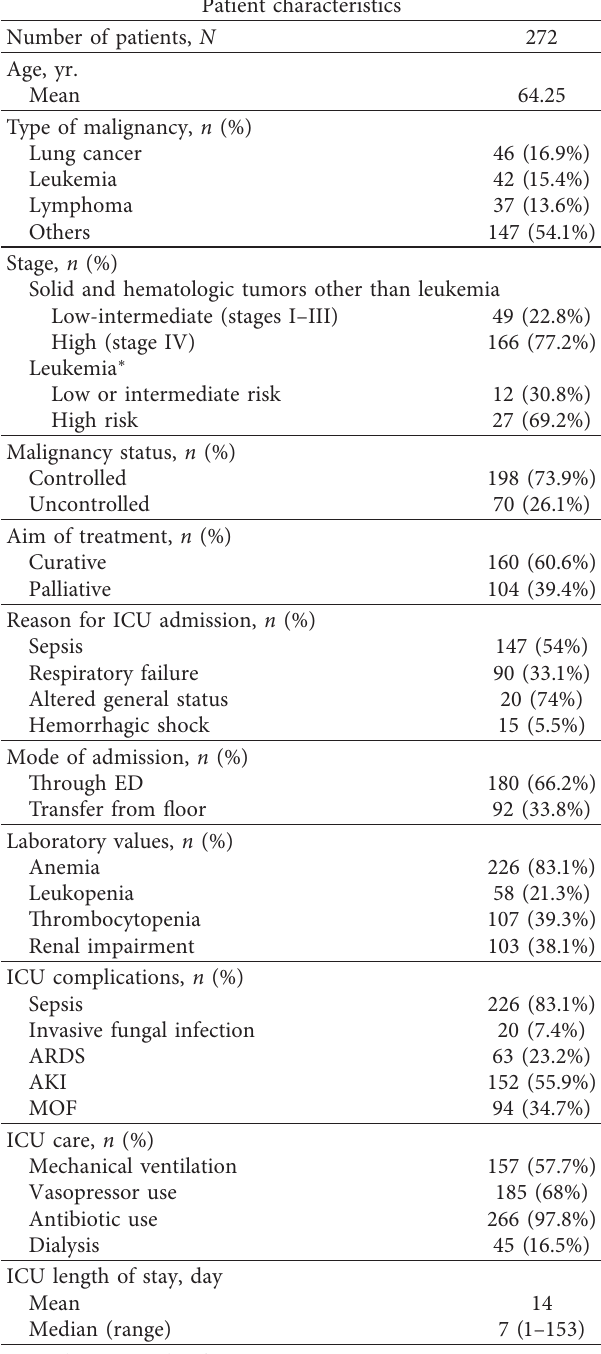
Table 1: Patient characteristics and ICU stay. Patient